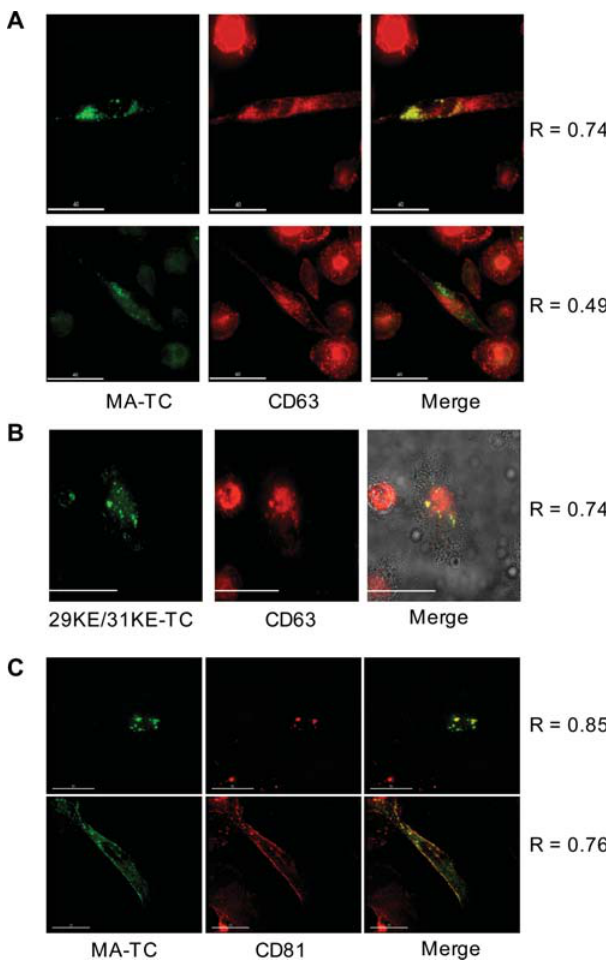
Figure 3. Gag in MDMs colocalizes with tetraspanins at the cell surface and in apparently internal compartments. MDMs infected with VSV-G-pseudotyped NL4-3/MA-TC (A and C) or NL4-3/ 29KE/31KE-TC (B) were labeled with FlAsH (green) 20 hours post- infection, fixed, and further labeled with antibody against CD63 (red) (A and B) or CD81 (red) (C). The merged images of Gag-TC and CD63/CD81 are shown on the right, with yellow indicating colocalization between Gag and CD63/CD81. R=Pearson coefficient of correlation. Scale